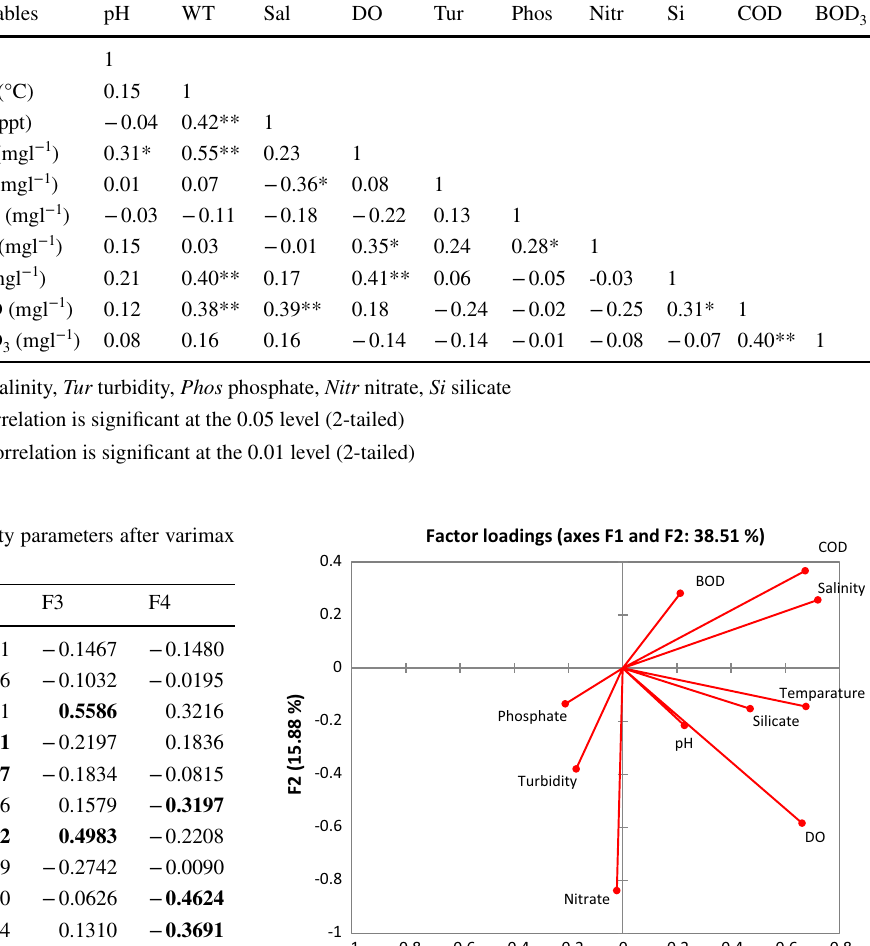
Table 3 Intra-relationship of environmental variables in Sundarbans